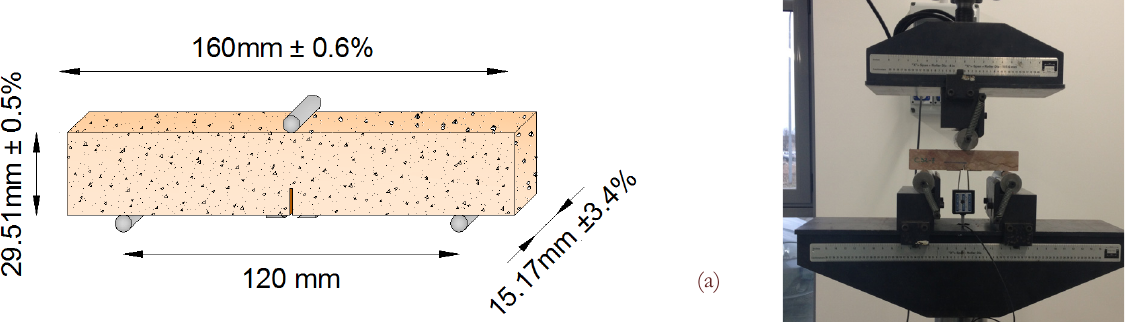
Figure 1: (a) Specimen geometry mean values and variations; (b) experimental set up of the Instron testing